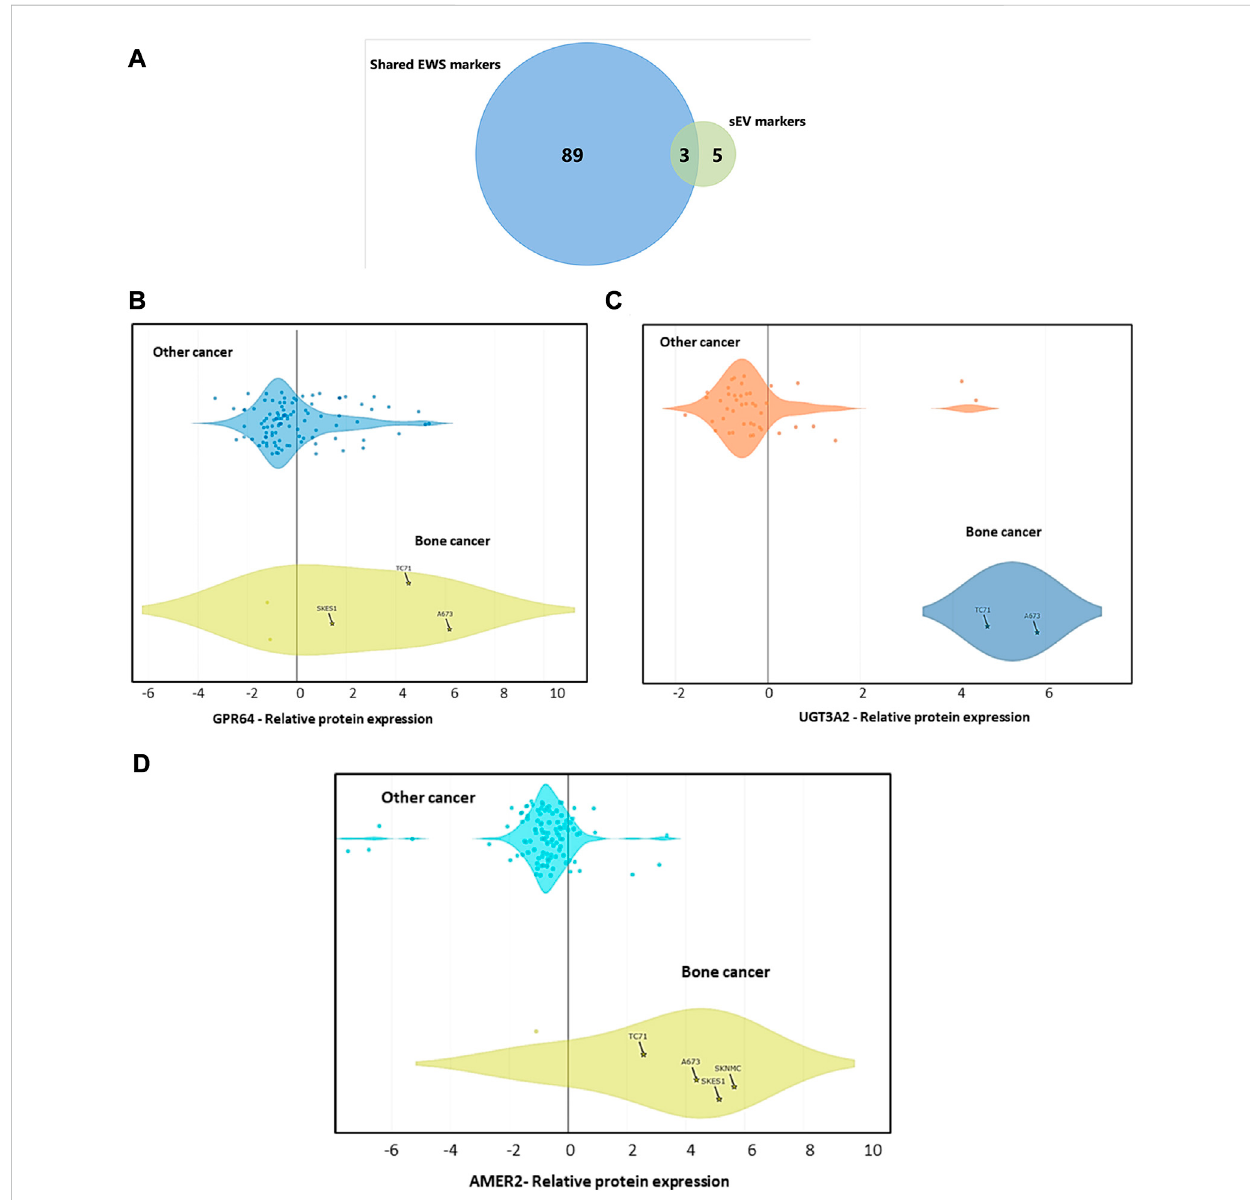
FIGURE 3 Protein Expression Data Across Different Cancer Cell Lines from DepMap Portal (A) Shared markers between cells and sEVs. Data explorer tool and proteomics database of DepMap portal has been used to generate violin plots representing the protein expression of (B) GPR64, (C) UGT3A2, and (D) AMER2 compared to other cancer